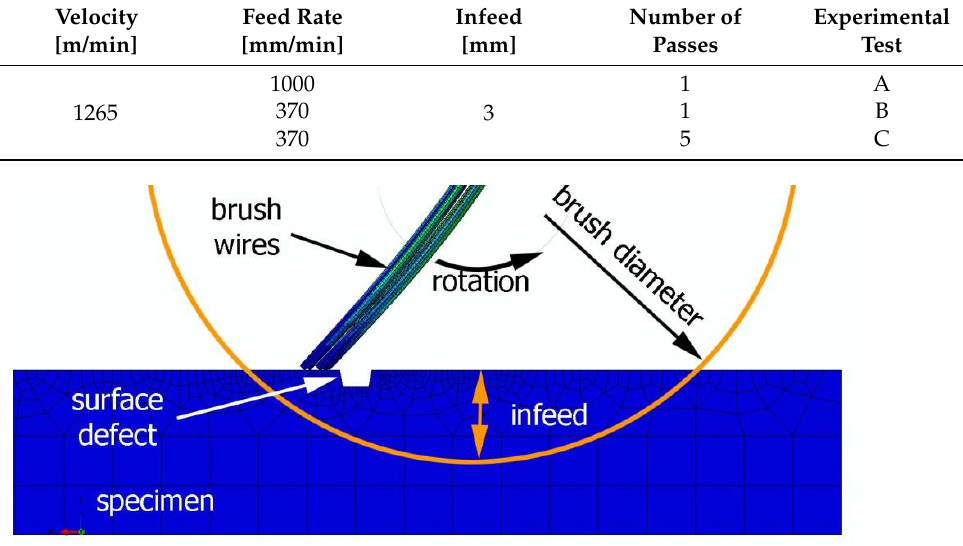
Figure 5. Simulation of the brushing process in Abaqus Explicit.